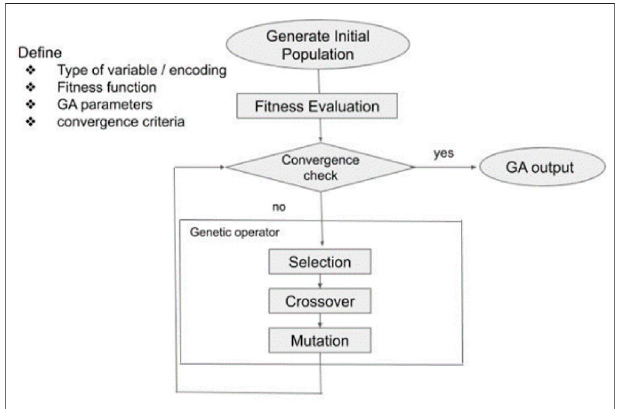
FIGURE 1 | Flowchart of the genetic algorithm.